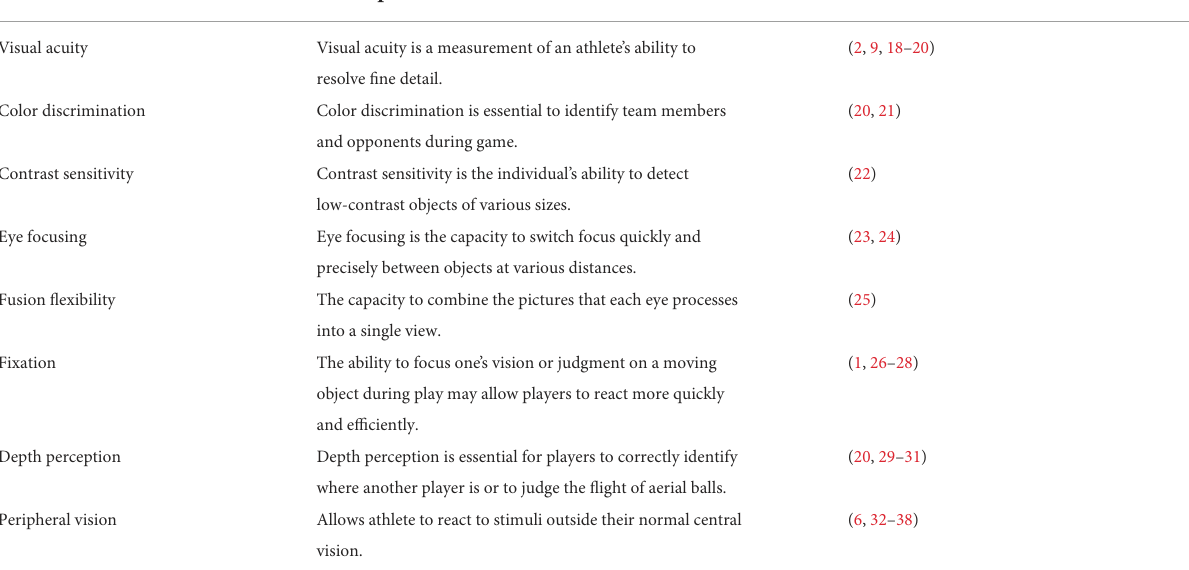
TABLE 1 Essential visual hardware skills for soccer